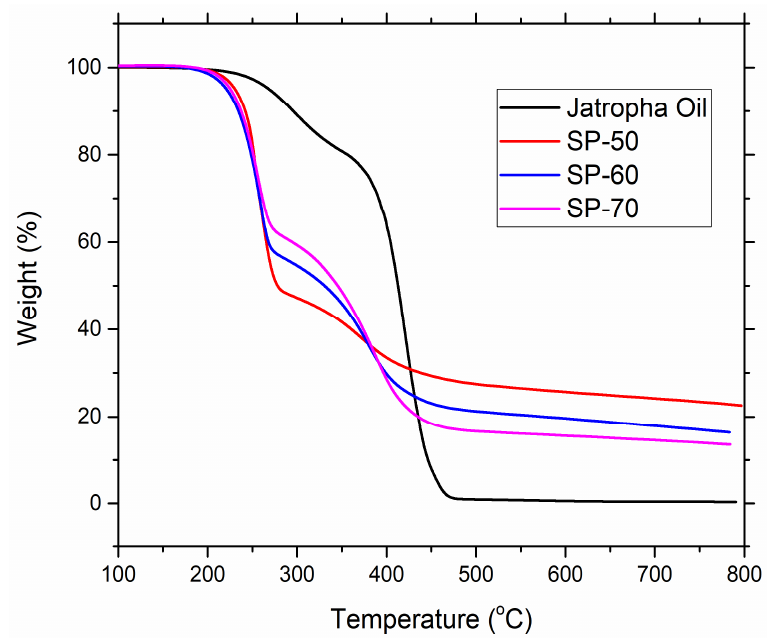
Figure 2. TGA thermograms of copolymers and oil.